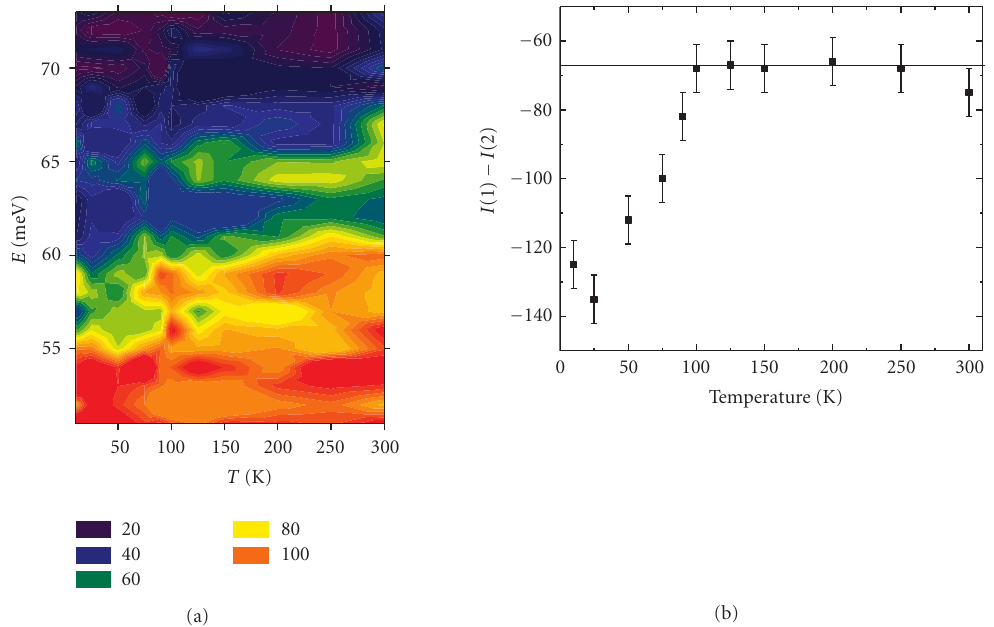
Figure 22: (b) Inelastic scattering intensity of YBa 2 Cu 3 O 6 . 95 at Q = (3 . 25,0,0) as a function of temperature, determined with the triple-axis spectrometer at the HFIR. Data were smoothed once to reduce noise. (a) Temperature dependence of the intensity di ff erence (I1)-(I2), where I(1) is the average intensity from 56 to 68meV, I2 from 51 to 55 eV, at Q = (3 . 25,0,0). T c of the sample was 93 K (from